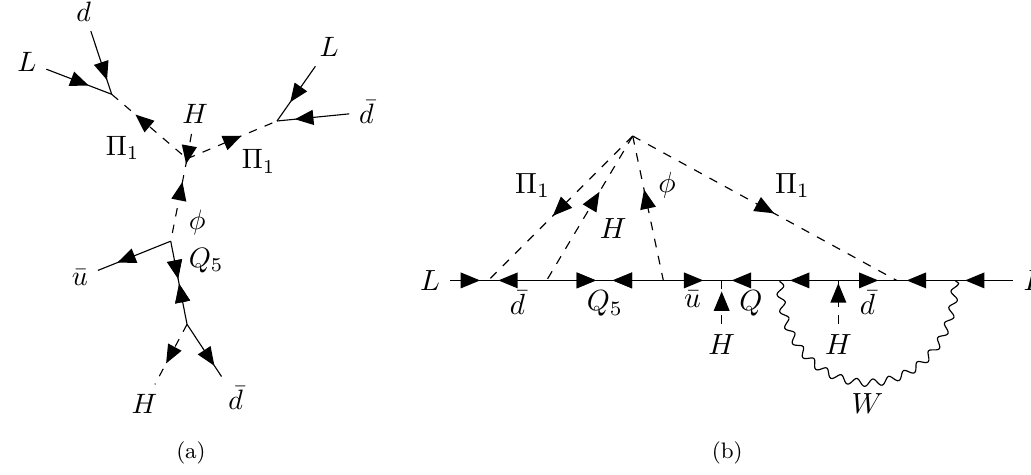
Figure 17. (a) The tree-level completion diagram for the model derived from exploding O 50 and discussed in the main text. The topology is 2 s 6 f 4 in our classification scheme. The closure involves an arrow-preserving loop connecting the ¯ d † to one of the ¯ d lines, and the W -boson closure motif discussed in section 4.1. (b) One of the neutrino-mass diagrams relevant to the model derived from O 50 . There is a three-loop diagram with the H line broken into an H † , H pair that generates the dimension-seven generalised Weinberg operator. The four-loop diagrams all involve connecting the H † to each of the three H legs in the diagram. There are also multiple places the W could end in the diagram, although it must couple to the Q line. The four-loop diagrams will give larger contributions to the neutrino mass than the three-loop diagrams for Λ & 2 TeV